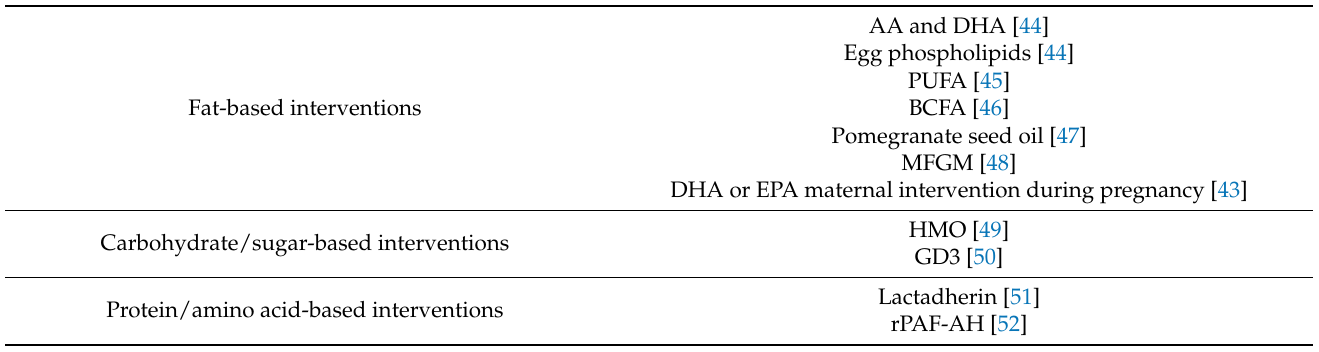
Table 1. Enteral feeding interventions reducing NEC incidence in experimental animal models of NEC.